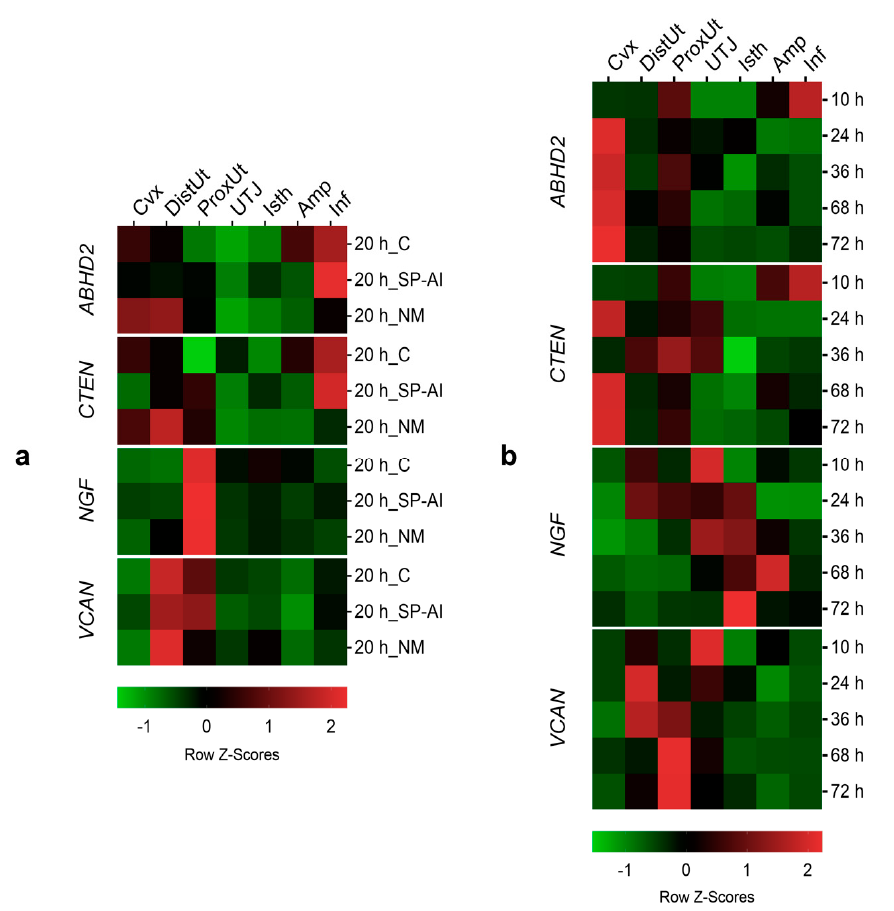
Figure 4. Gene expression changes among tissues in the different groups included in the study. Changes in ABHD2 , CTEN , NGF , and VCAN expression among different tissues (endocervix, Cvx; distal uterus, DistUt; proximal uterus, ProxUt; utero-tubal junction, UTJ; distal isthmus, Isth; ampulla, Amp; and infundibulum, Inf) ( a ) at 20 h after the induction of ovulation with 0.03 mg of gonadotropin-releasing hormone (GnRH) intramuscularly, as the control of ovulation (20 h_C); 20 h post-GnRH-stimulation and sperm-free seminal plasma vaginal infusion (20 h_SP-AI); and 20 h post-GnRH-stimulation and natural mating (20 h_NM); ( b ) at 10, 24, 36, 68, and 72 h post-GnRH-stimulation and natural mating. Row Z-Scores of the mean fold change relative to the reference group (UTJ) are shown. Red indicates upregulation and green indicates downregulation.